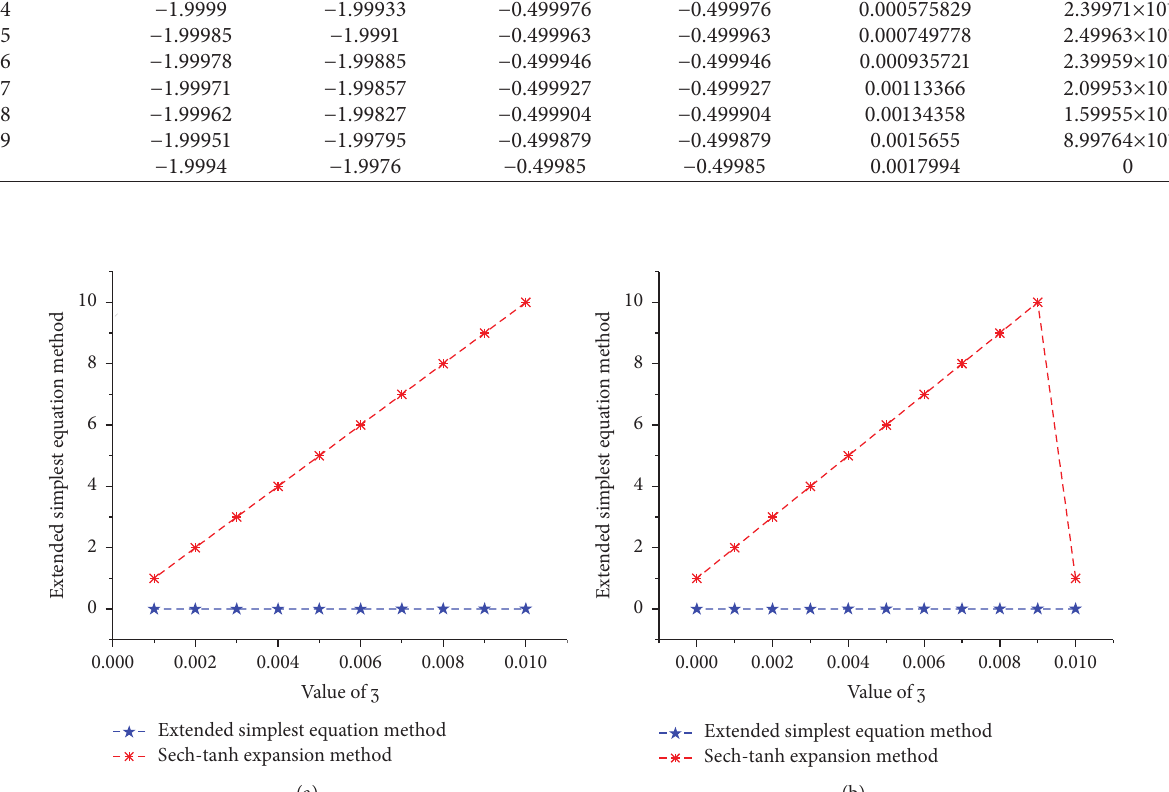
Figure 7: Absolute value of error via the Adomian decomposition method (a) and cubic B-spline scheme (b) based on the shown value in Tables 1 and